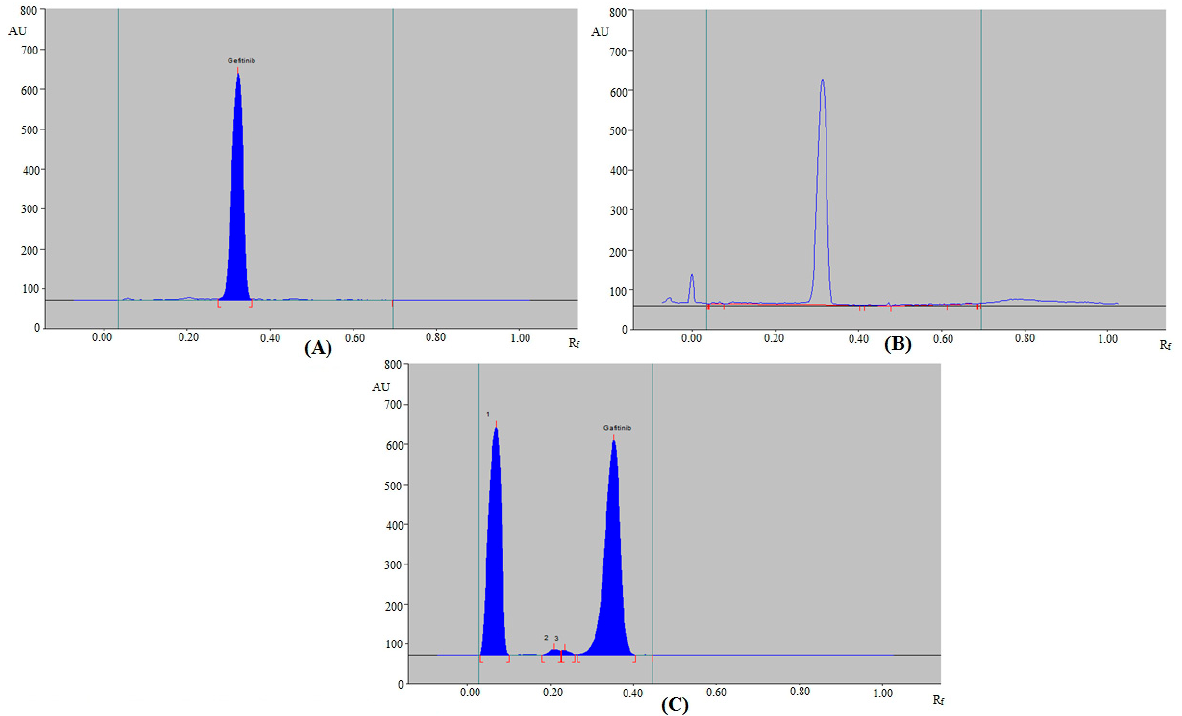
Figure 3. HPTLC densitograms of GFT obtained under ( A ) acid degradation, ( B ) base degradation, and ( C ) oxidative degradation of GFT using the routine HPTLC method.